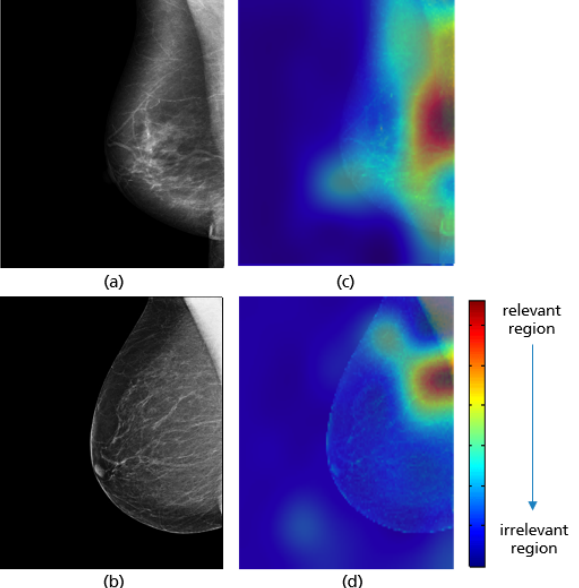
Figure 21. MLO views showing adequate ( a ) and poor positioning quality ( b ) with regard to the level of the pectoralis muscle and their Grad-CAM ( c , d ) highlighting the relevant region for the model